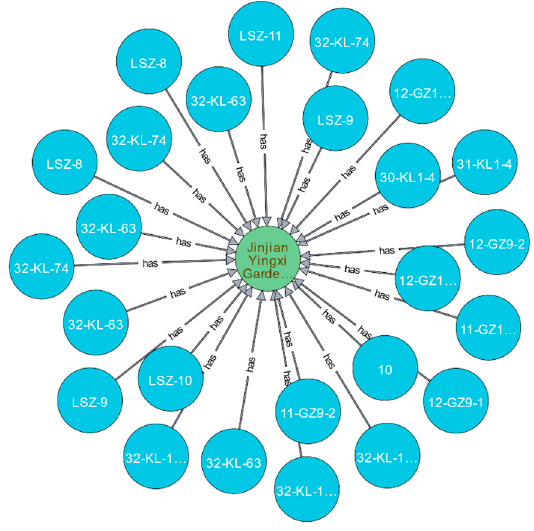
Figure 5. Storage structure of nodes in Neo4j.